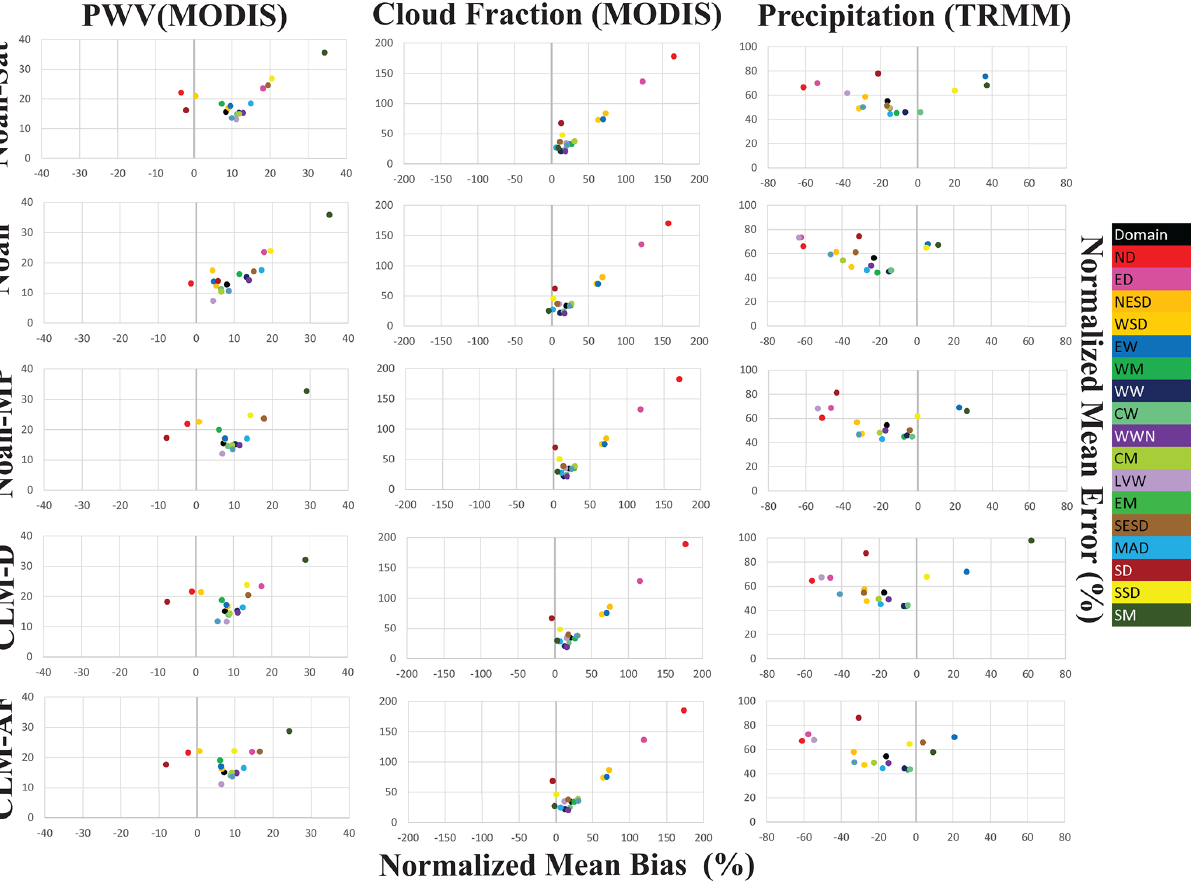
Figure 10. Normalized mean error and mean bias statistics of PWV, cloud fraction, and precipitation relative to observed MODIS PWV and cloud fraction and TRMM